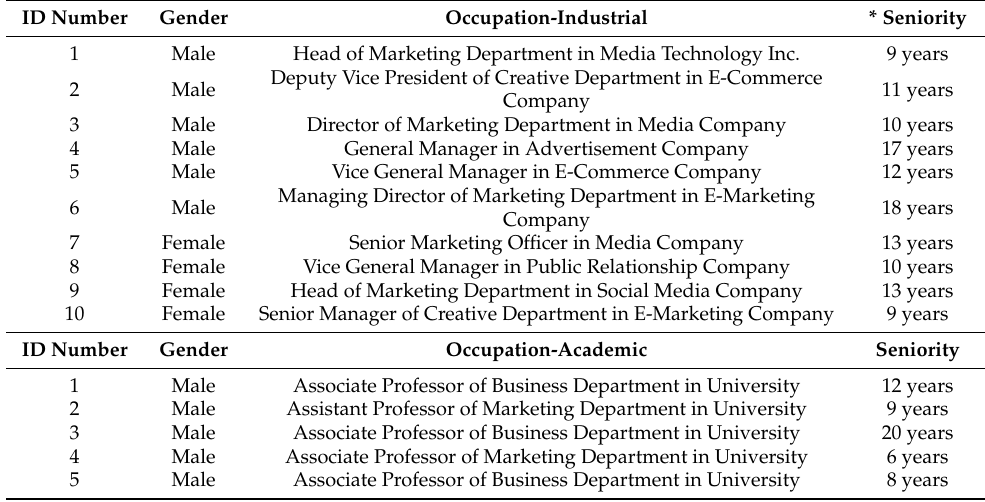
Table 1. Interviewee